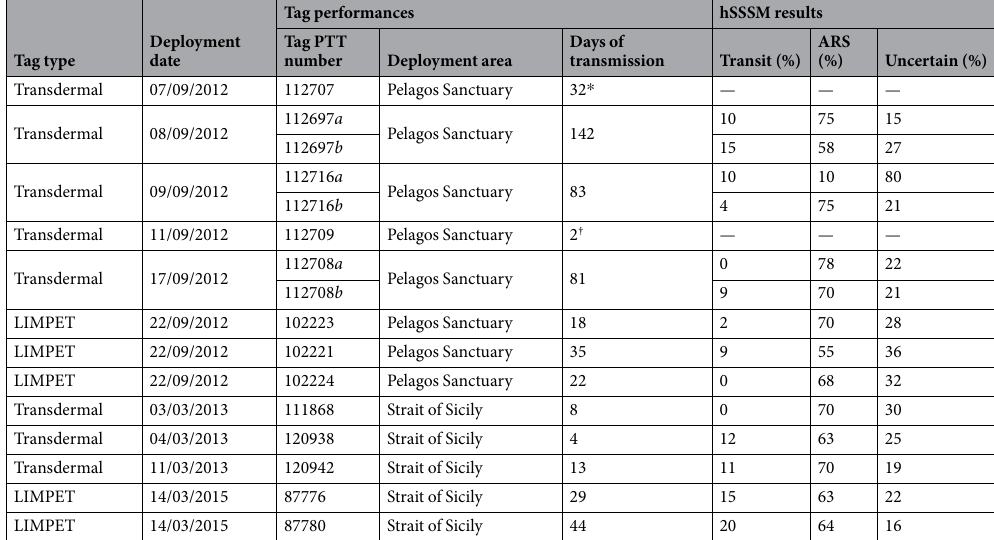
Table 1. Summary of tag performances. For each individual fin whale, the percentage of locations where the behavioural state was classified as transiting, ARS or uncertain (based on Jonsen et al .’s 62 conservative cut-off values) is reported. The uncertain category indicates locations where the model could not distinguish conclusively between the two behavioural modes, either because of intermediate characteristics of the movement process or of large Argos error (see Supplementary Information for additional details). When the temporal gap between consecutive locations was longer than four days, tracks were split into separate segments for the analysis. These are indicated here with the letter a and b , respectively. * No location, only transmissions were received from this tag thus it was not included in the analysis; † The hSSSM analysis was not performed for this tag given its relatively short